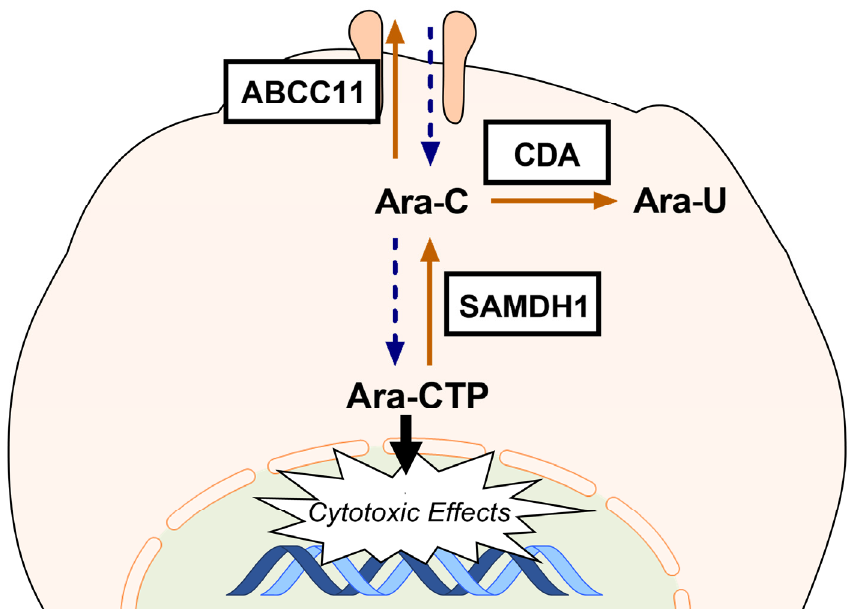
Figure 7. Role of SAMHD1, CDA, and ABCC11 in Ara-C metabolism. ATP-binding cassette C11 (ABCC11) functions as a nucleotide efflux pump and reduces the intracellular levels of Ara-C; cytidine deaminase (CDA) irreversibly deaminates Ara-C to its inactive uracil derivative uracil arabinoside